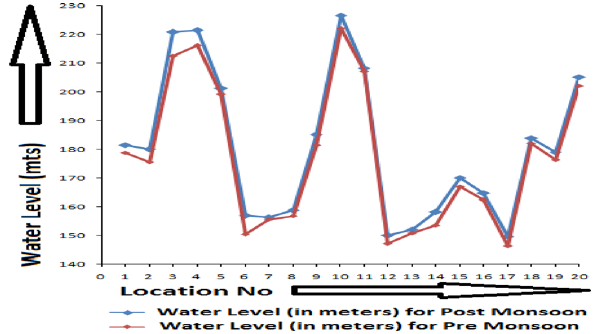
Fig. 2 Hydrograph representing variation in water tables (m) for both sampling